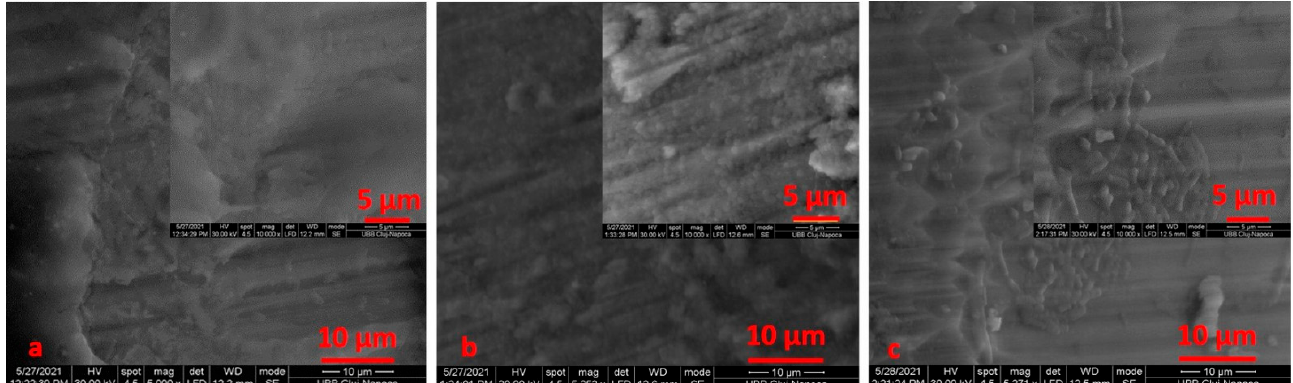
Figure 15. SEM images that highlight the formation of bacterial colonies on the screw surface: ( a ) new and untreated; ( b ) after electrochemical treatment using Ringer’s Solution; ( c ) after electrochemical treatment using 1:1 citric acid: phosphoric acid solution.